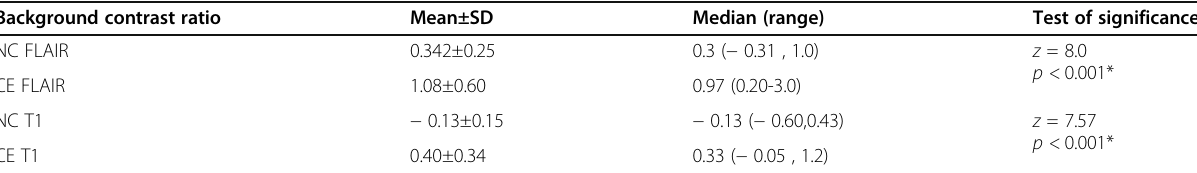
Table 3 Lesion to background contrast ratio Background contrast ratio